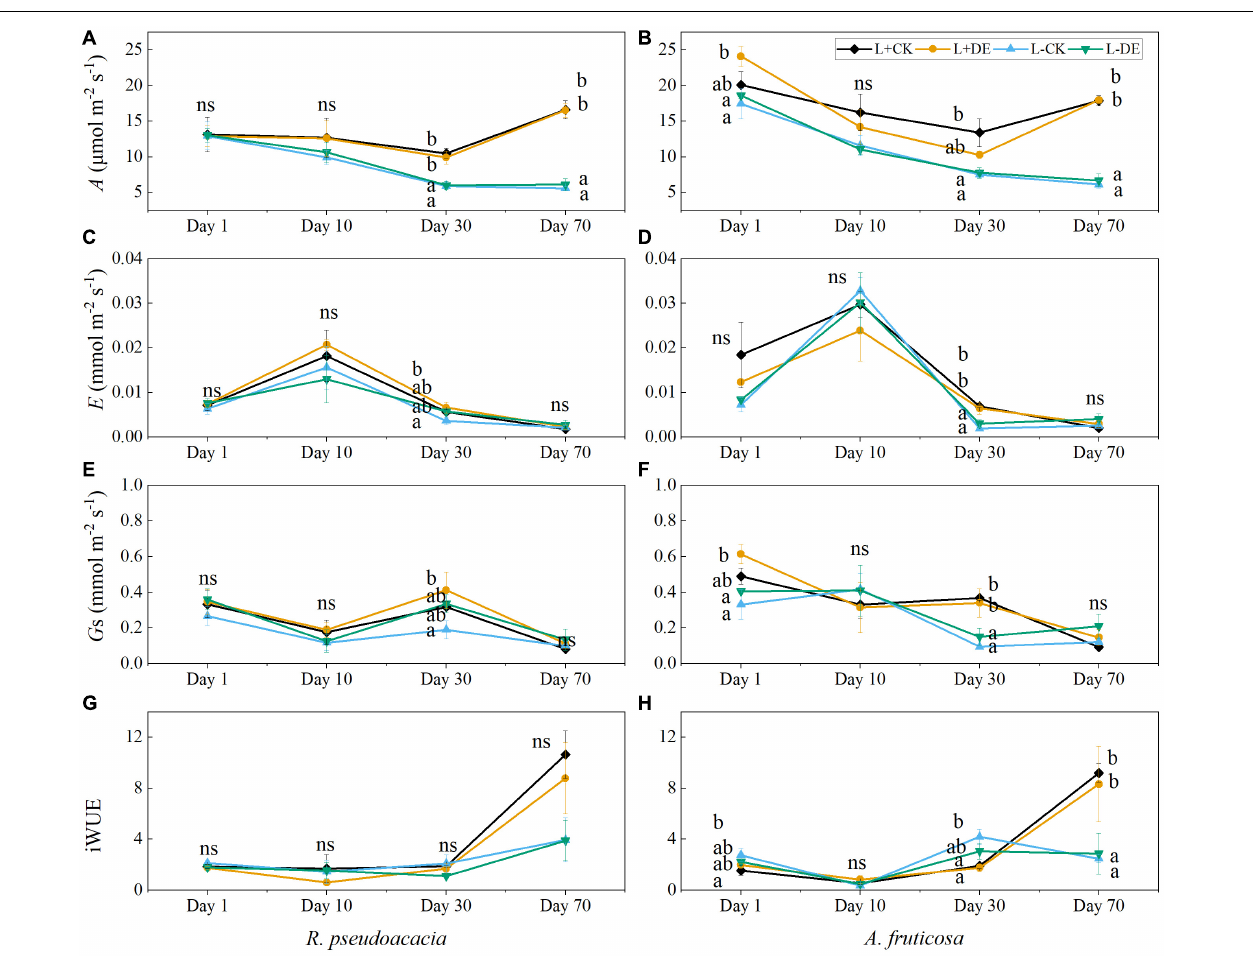
FIGURE 5 | Seedling gas exchange parameters of R. pseudoacacia (A,C,E,G) and A. fruticosa (B,D,F,H) under different light and defoliation treatments. The values are shown as mean ± SE ( n = 4). Different letters indicate significant differences among different treatments in each sampling according to Duncan’s test ( p < 0.05). L + CK, high light condition with no defoliation; L + DE, high light condition treatment with defoliation; L − CK, low light condition with no defoliation; L − DE, low light condition with